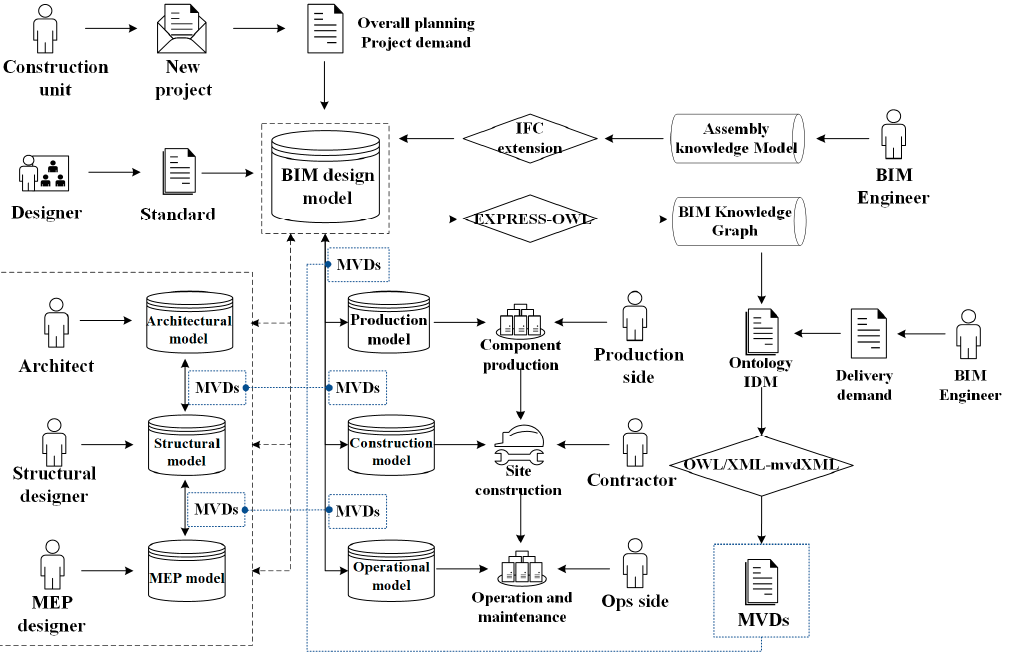
Figure 17. Information delivery management model of forward design for prefabricated buildings.